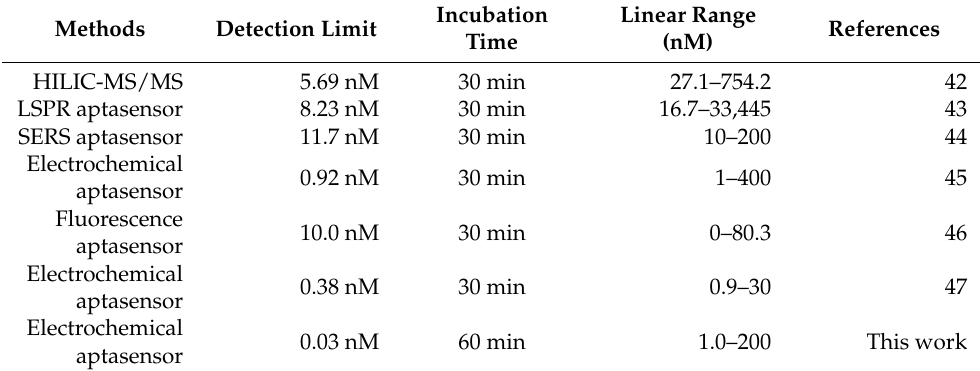
Table 1. Comparison of the performances of various STX aptasensors